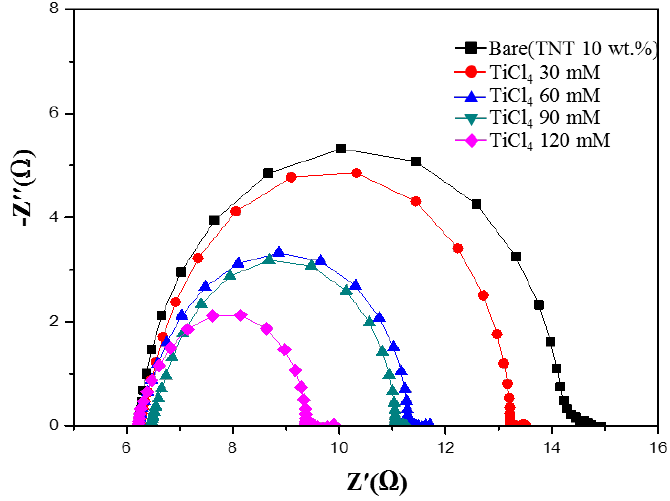
Figure 8. I – V characteristic of TiCl